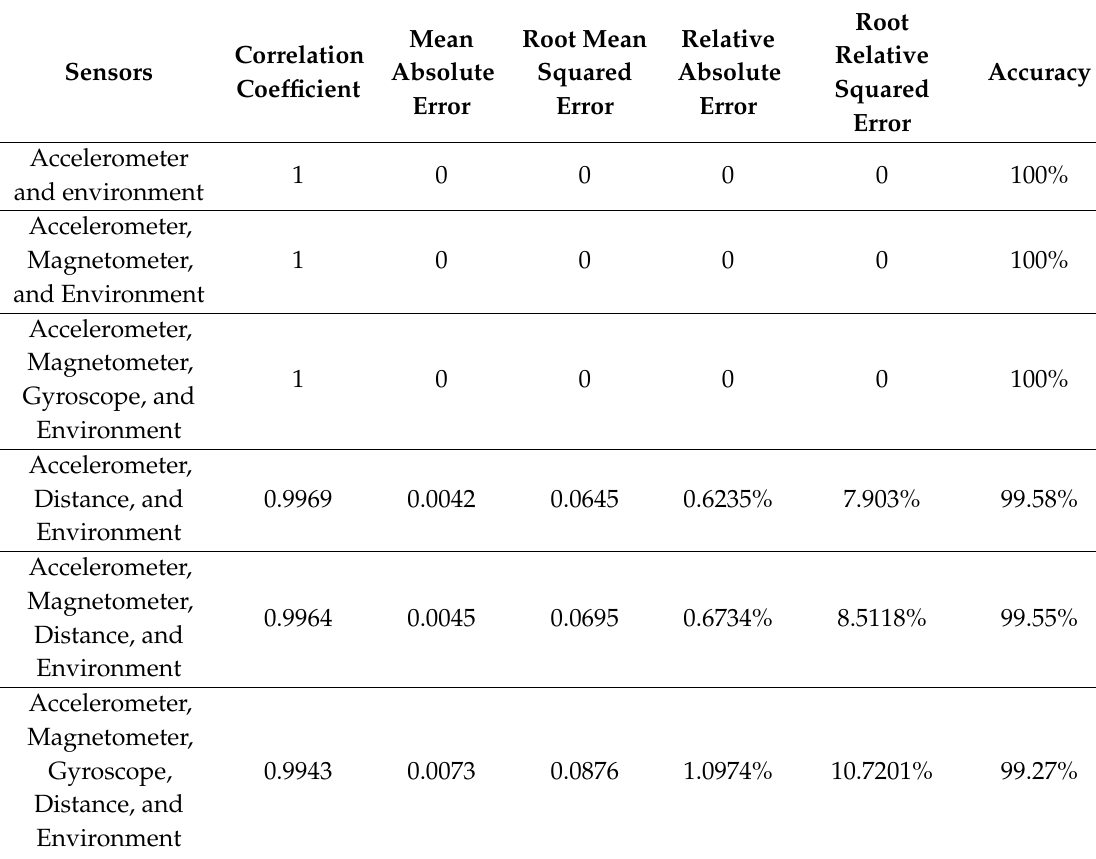
Table 12. Accuracies of the recognition of activities without motion using the IBk method implemented with Weka